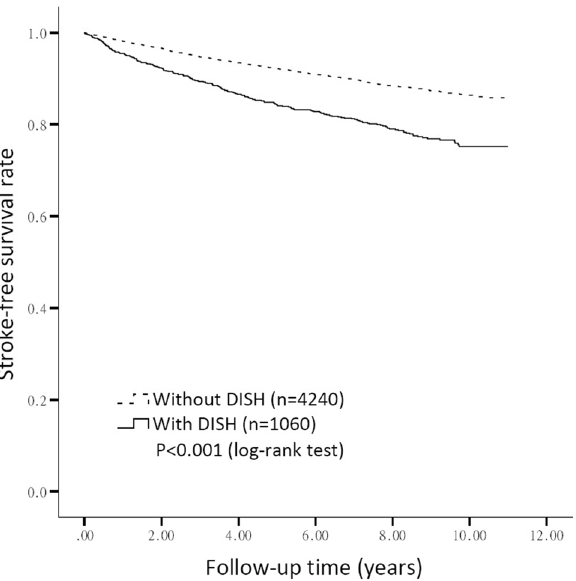
Figure 1. The Kaplan–Meier survival analysis of the stroke-free survival rate in patients with and without diffuse idiopathic skeletal hyperostosis. We used SAS software, version 9.4 (SAS Institute Inc., Cary, NC, USA) for statistical analysis in this